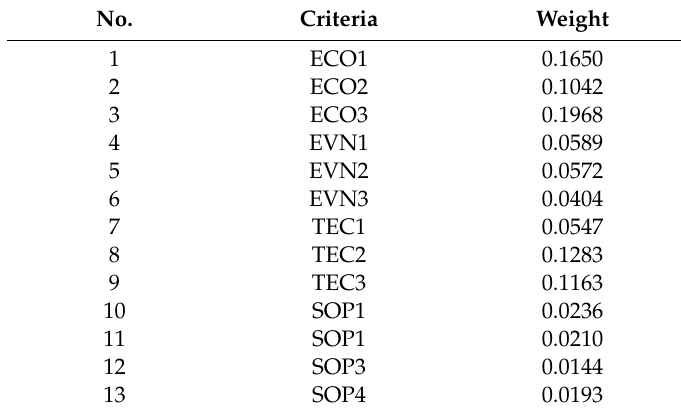
Figure 6. General hierarchy structure of proposed model. Table 2. Weight of all of the subcriteria. ECO—economic; EVN—environmental; TEC—technical; SOP—socio-political.